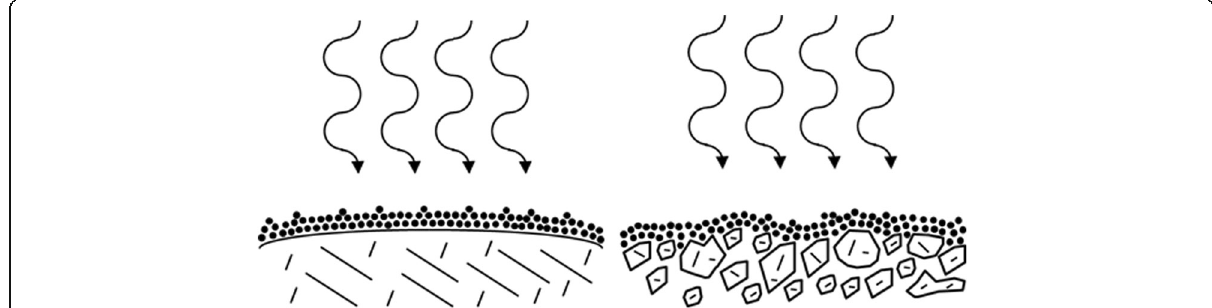
Fig. 1 Left: Two-layer model of an irradiated surface consisting of competent bedrock covered by a thin dust layer. For the rock, a thermal inertia of 1183 J m − 2 K − 1 s − 1/2 will be assumed, while the dust layer has a thermal inertia of 25 J m − 2 K − 1 s − 1/2 (compare Table 1). Average dust thickness is δ . Right: same as left, but for a dust-covered porous rock or coarse regolith with thermal inertia 300 J m − 2 K − 1 s − 1/2